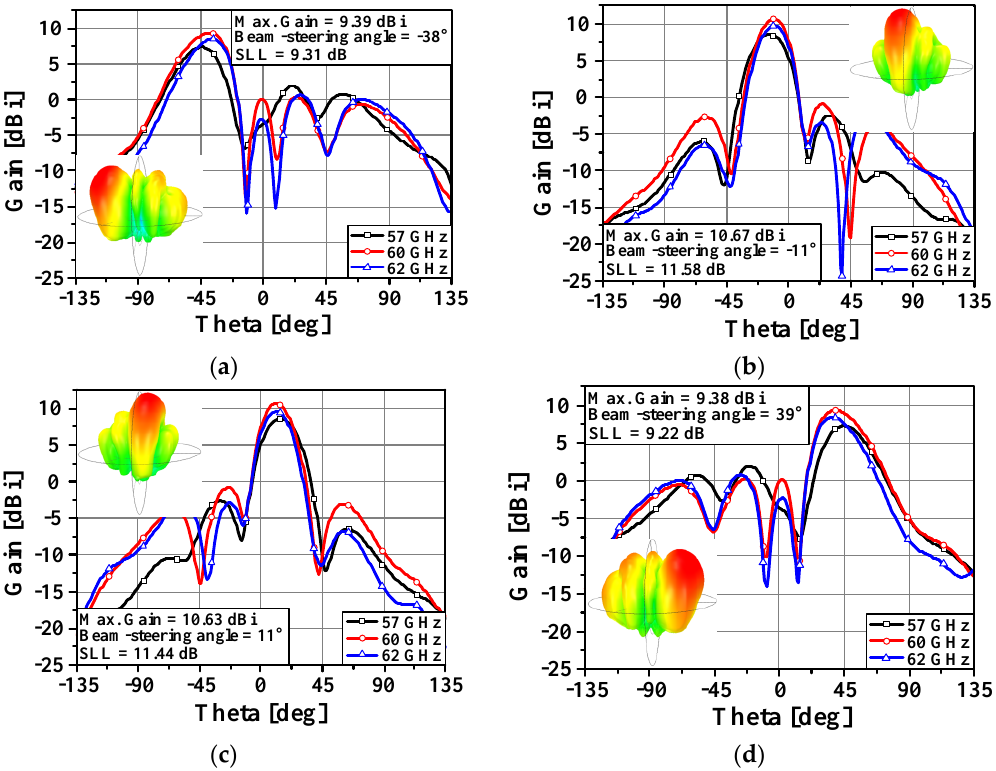
Figure 12. Simulated gain patterns of the proposed antenna array system with the excitation of ( a ) port 2, ( b ) port 4, ( c ) port 5, and ( d ) port 7.